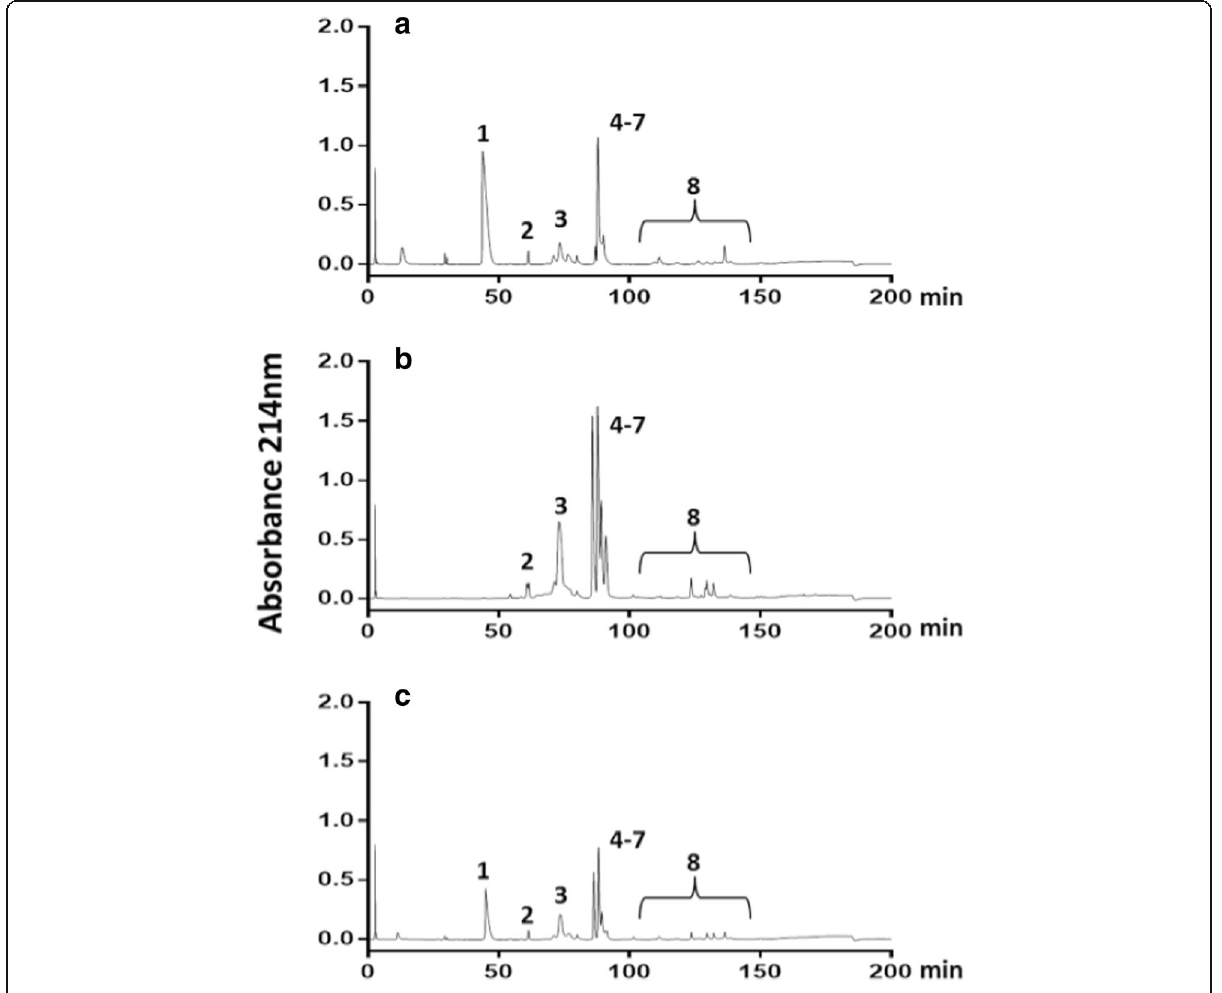
Fig. 2 Analyses of Crotalus durissus terrificus venoms by RP-HPLC. The venoms of C. d. terrificus (batches 2014CDU00301 and 2014CDU00201) were pooled from ( a ) crotamine-positive specimens collected in southern and ( b ) crotamine-negative specimens collected in southeastern Brazil, respectively. The pooled venom for immunization was obtained by combining ( c ) the same ratio of crotamine-positive and crotamine- negative venoms. The elution conditions were: isocratic gradient with 5% of 0.1% TFA in 100% of acetonitrile (solvent B for 10 min followed by 5 – 15% B for 20 min, 15 – 45% B for 120 min and 45 – 70% B for 20 min, with a final isocratic step of 70% B for 5 min at a flow rate of 1 mL/ min. Protein families associated with HPLC peaks were: 1 – crotamine, 2 – disintegrin, 3 – crotoxin acid chain, 4 to 7 – crotoxin basic chain, and 8 – fractions of low expression toxins including D49-PLA 2 , serine protease (gyroxin), C-type lectin (convulxin) and